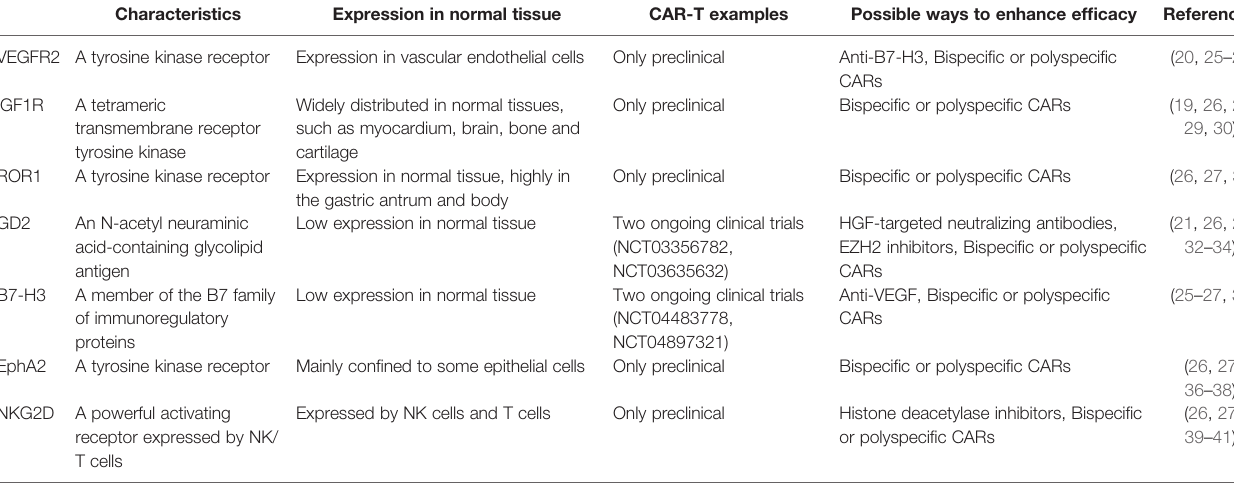
TABLE 1 | Targets of CAR-T in